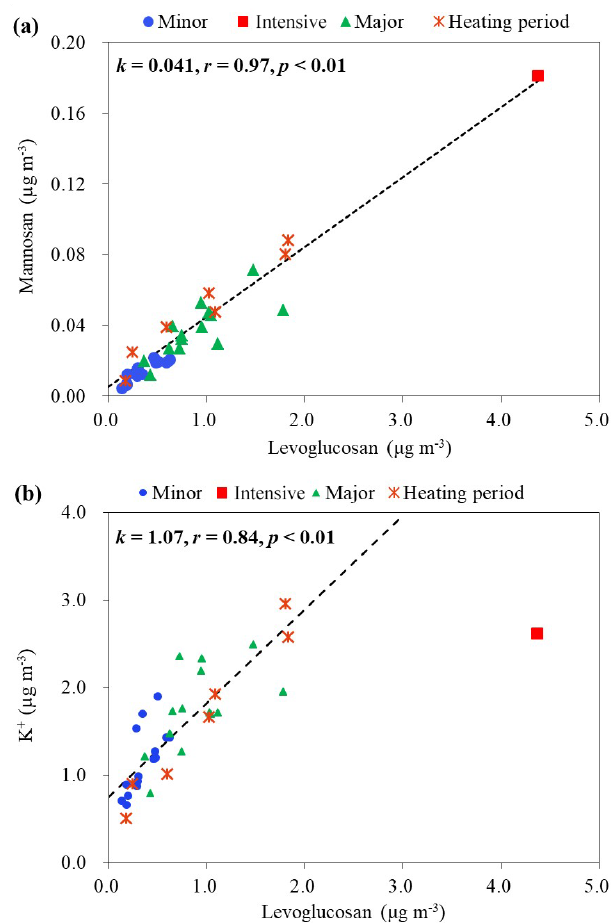
Figure 7. Scatter plots of (a) levoglucosan versus mannosan, (b) levoglucosan versus K + . Statistical analysis of sampling data was conducted with the linear fitting